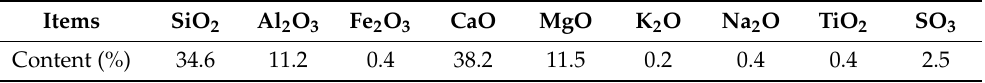
Table 2. The chemical compositions of the slag for mixing with Portland cement.